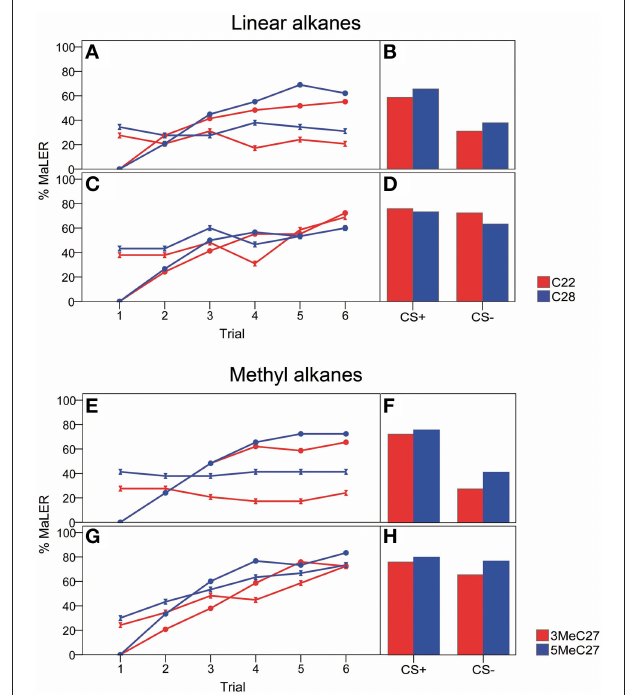
FIGURE 2 | Narrow range: acquisition curves and retention tests for linear (C 22 , C 28 ) and methyl alkanes (3-MeC 27 and 5-MeC 27 ) showing the response probability to the narrow concentration range expressed as the proportion of ants extending their maxilla-labium (MaLER). In the acquisition curves (A,C,E,G) , responses to the CS are shown by circles (CS + ) or double triangles (CS − ). Retention tests show the proportion of ants responding to both CS + and CS − 1h after the training. (A,B,E,F) low concentration rewarded, high concentration punished (low + /high − vs. high + /low − ); (C,D,G,H) high concentration rewarded, low concentration punished (high + /low − vs. low + /high −